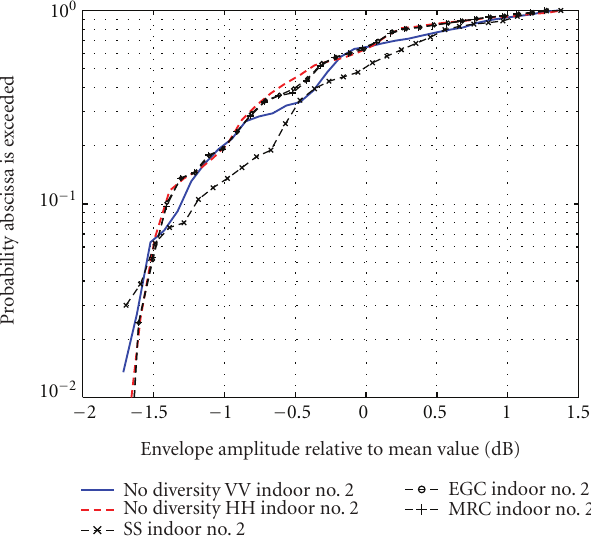
Figure 5: CDFs for di ff erent combination methods in indoor number 1 scenario at 41.4 GHz.